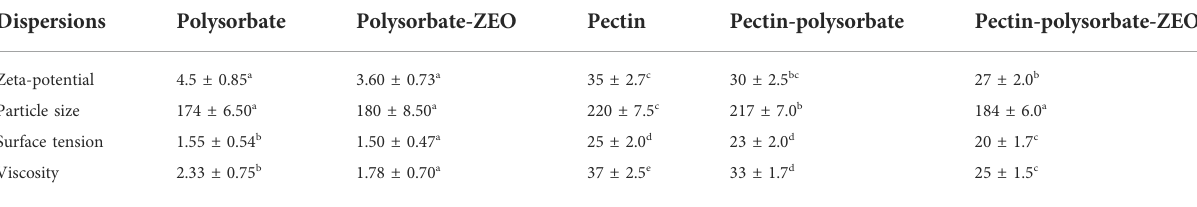
TABLE 1 Zeta-potential (mV), particle sizes (nm), surface tension (mN/m), and viscosity (mPa . s, at a shear rate of 10 s − 1 ) of apple pectin incorporated with Zataria essential oil (ZEO